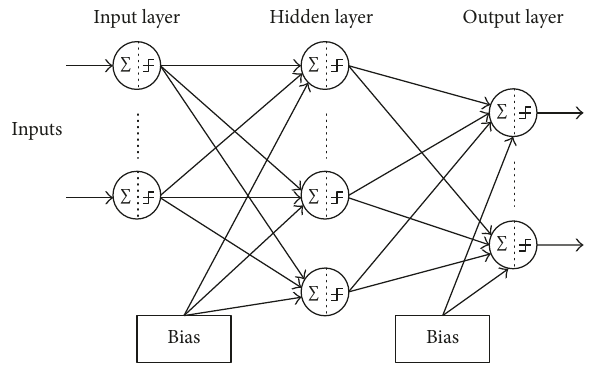
Figure 8: Multilayer feed-forward neural network structure.